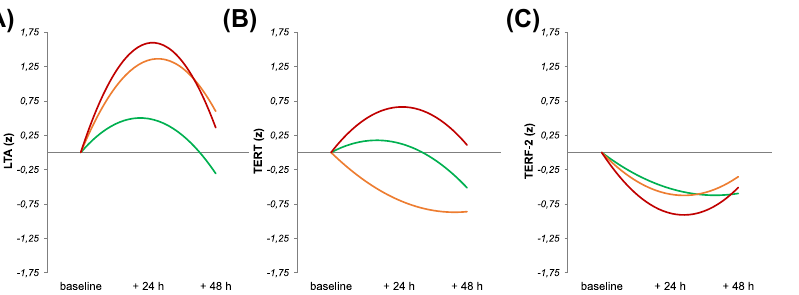
Figure 2: Dynamics of telomere-associated markers before and after low (green, n=7), moderate (orange, n=7) and high (red n=7) intensity exercise sessions.